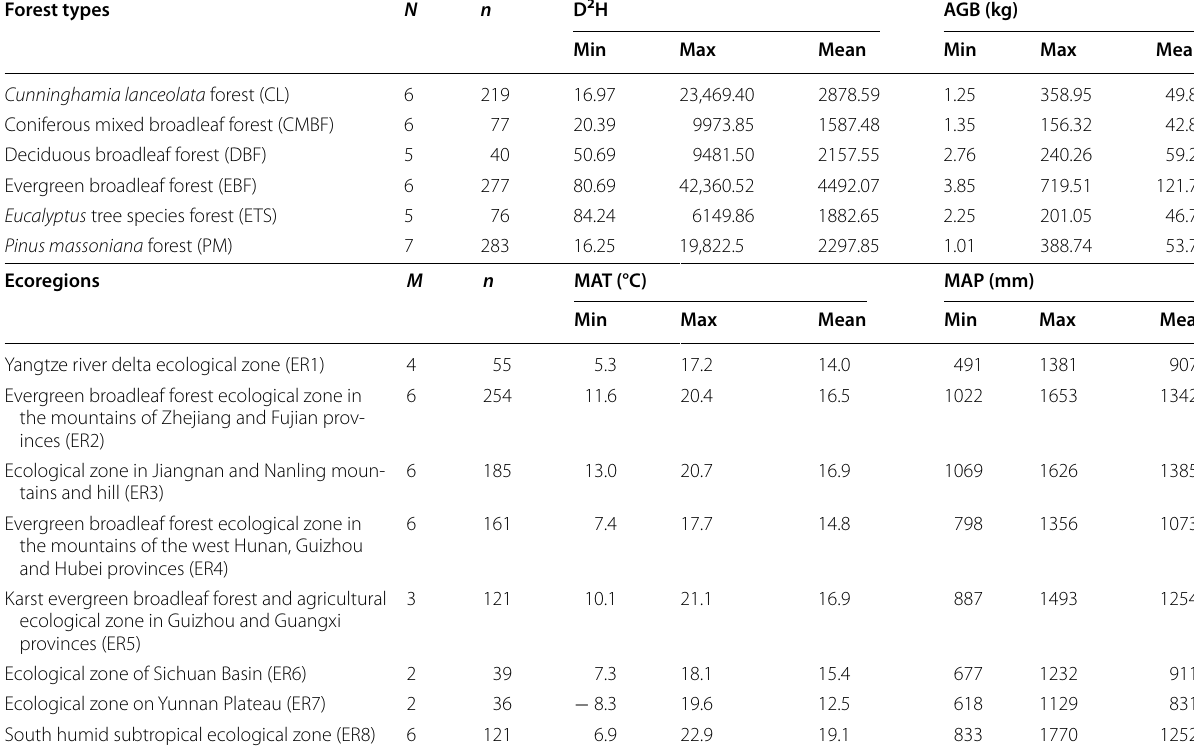
Abbreviations in the brackets indicated each forest type and individual ecoregion, respectively in the subtropical region of China. Climate data, including mean annual temperature (MAT) and mean annual precipitation (MAP) was obtained from the National Climate Center (http://ncc.cma.gov.cn/cn/) N number of forest distributed ecoregions, n number of sampling plots, M number of forest